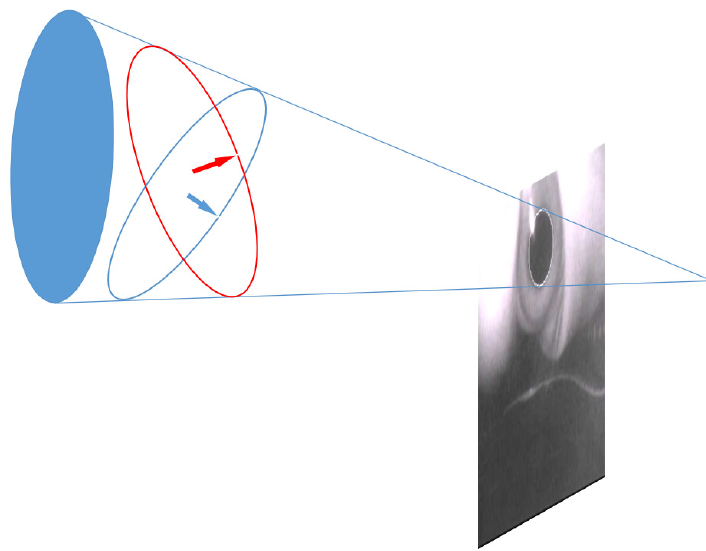
Figure 43. Pupil elliptical reflection projection [9].